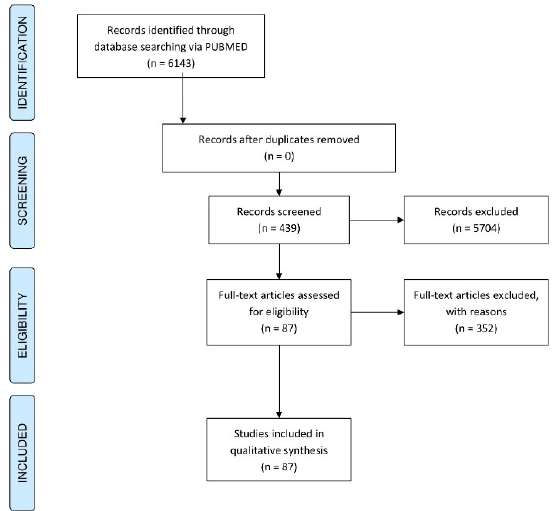
Figure 1. PRISMA flow diagram indicating the steps of article screening for a systematic